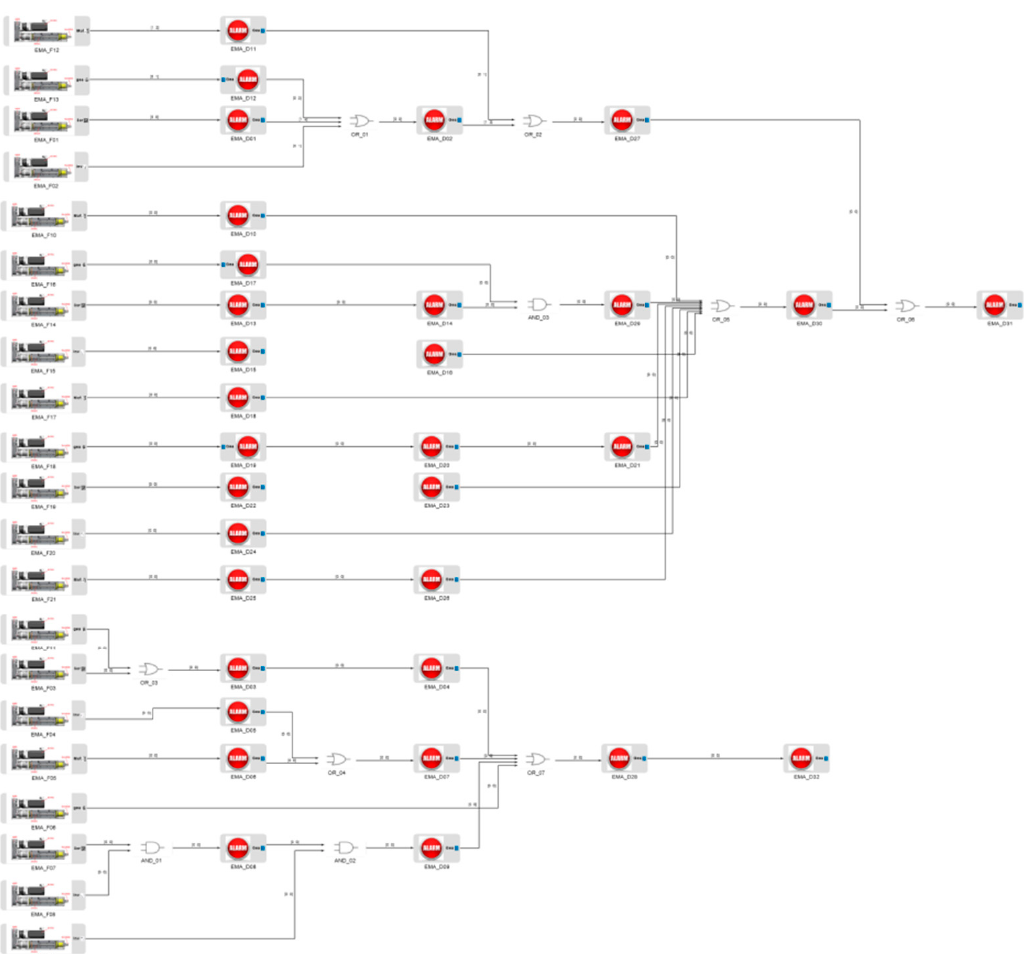
Electronics 2020 , 9 , x FOR PEER REVIEW Figure A4. The alarm model of EMA in GME. Figure A4. The alarm model of EMA in GME.